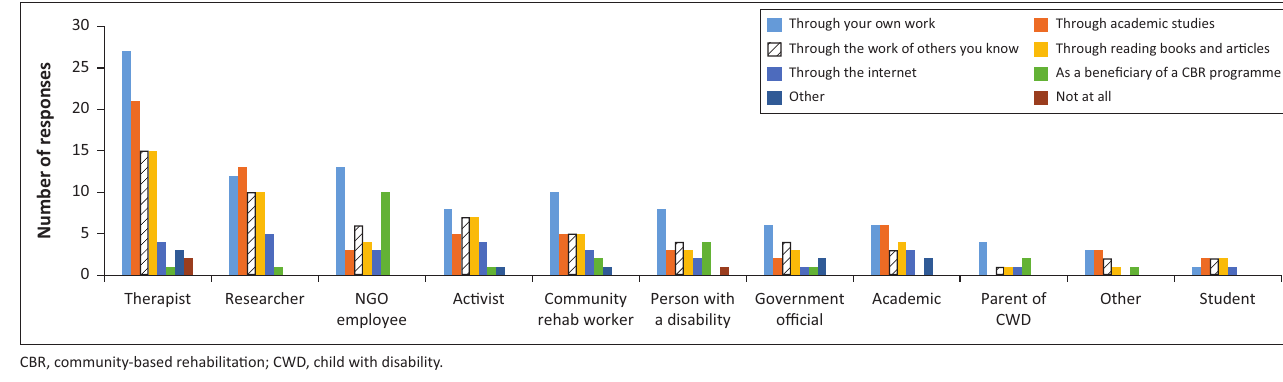
FIG URE 2: Cross-tabulation of respondent category with exposure to community-based rehabilitation (multiple responses